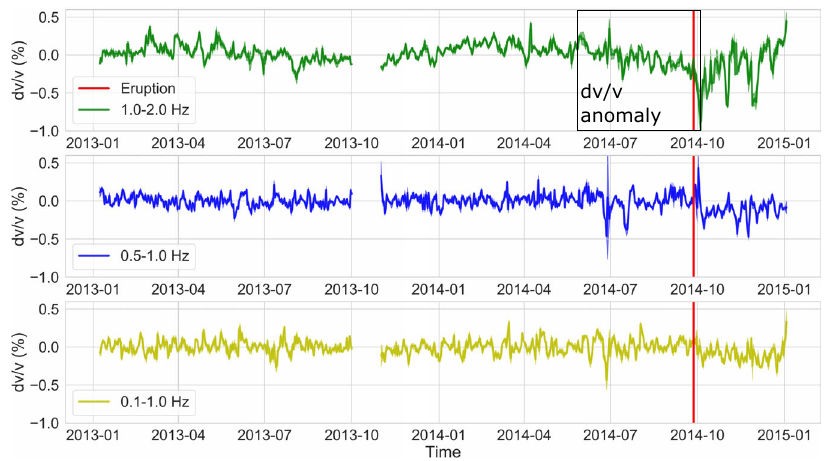
Fig. 2 | Relative velocity variations from AC. Temporal evolution of relative seismicvelocity atstation ONTAusing different frequencybands(1.0 – 2.0, 0.5 – 1.0, and 0.1 – 1.0Hz). The vertical red line indicates the 27 September 2014 eruption.